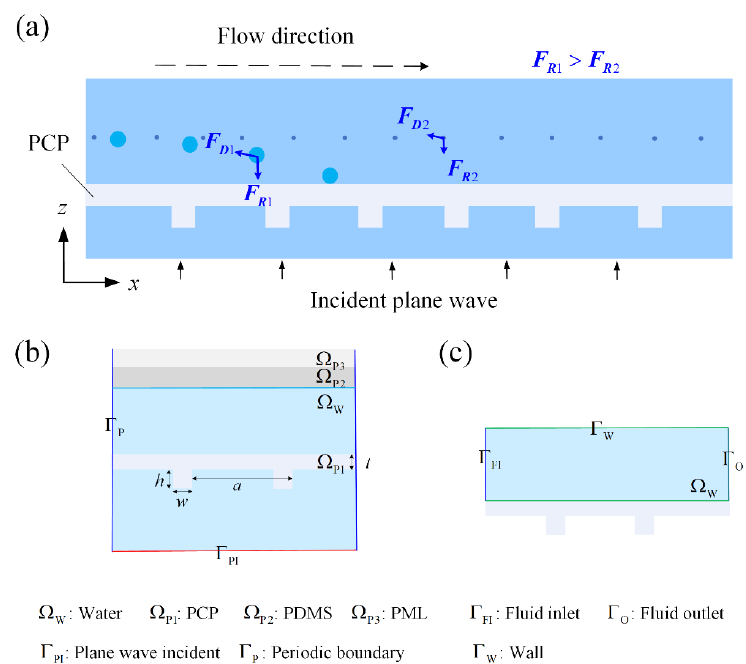
Figure 1. ( a ) Schematic of PCP-based particle sieving. The acoustic radiation force produced by a resonant PCP traps large particles from mixed samples under the flow condition. Simulation model and boundary conditions for calculating ( b ) the first-order acoustic field and ( c ) streaming field.